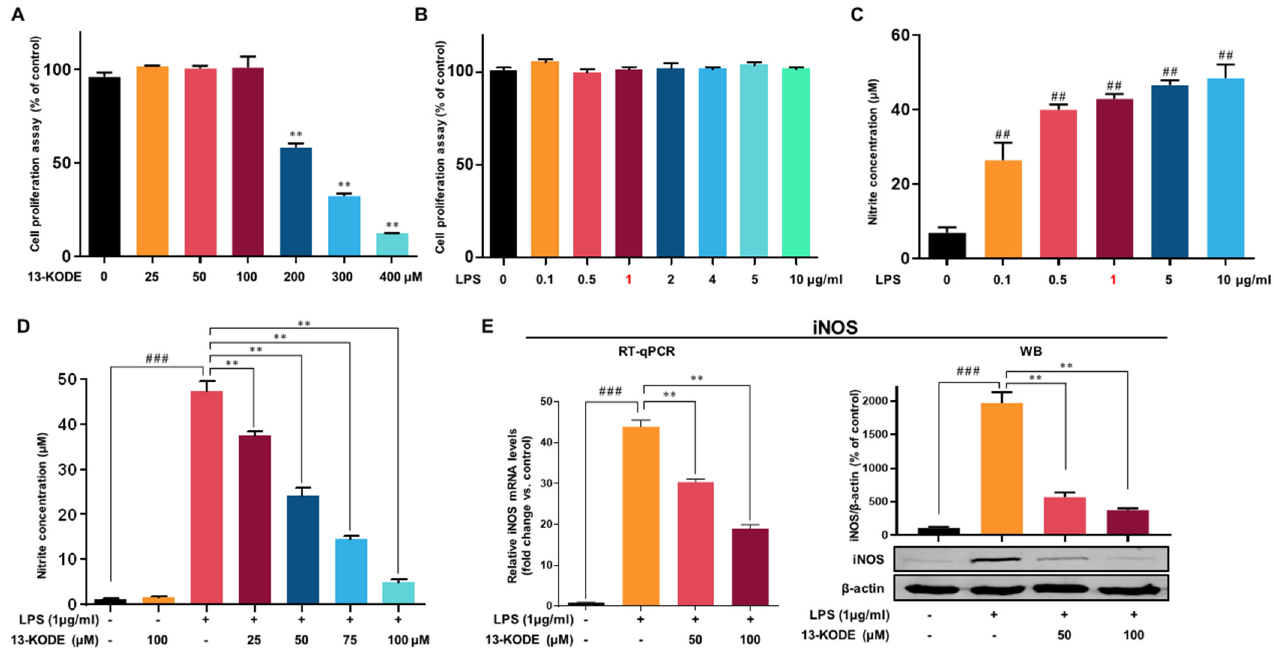
Figure 2. Effect of 13-KODE on cell proliferation and LPS-induced NO secretion and expression of the iNOS gene in RAW 264.7 macrophages. The cells were cultured with the indicated concentrations of 13-KODE and LPS. ( A , B ) Cell proliferation was determined with WST (4-[3-(4-Iodophenyl)-2-(4-nitro-phenyl)-2H-5-tetrazolio]-1,3-benzene sulfonate). The results are shown as the percentage of surviving cells compared with control cells (without 13-KODE and LPS). ( C ) RAW 264.7 macrophage cells were treated with several concentrations of LPS for 24 h, and NO production was determined using the NO assay. ( D ) RAW 264.7 cells (4 × 10 5 cells/well in six-well plates) were left untreated or were pretreated with 13-KODE (25, 50, 75, and 100 µM) prior to treatment with LPS (1 µg/mL) for 24 h. ( E ) Total RNA was purified from RAW 264.7 macrophage cells with or without the indicated concentrations of 13-KODE and treated with LPS (1 µg/mL) for 24 h. The transcripts of iNOS were measured by quantitative reverse transcription polymerase chain reaction as described in Section 2. Protein lysates were isolated from the cells with or without 13-KODE and then stimulated with LPS (1 µg/mL) for 24 h. The values correspond to the mean ± standard deviation, n = 3. ## p < 0.01; ### p < 0.001; ** p < 0.01; *** p < 0.001.